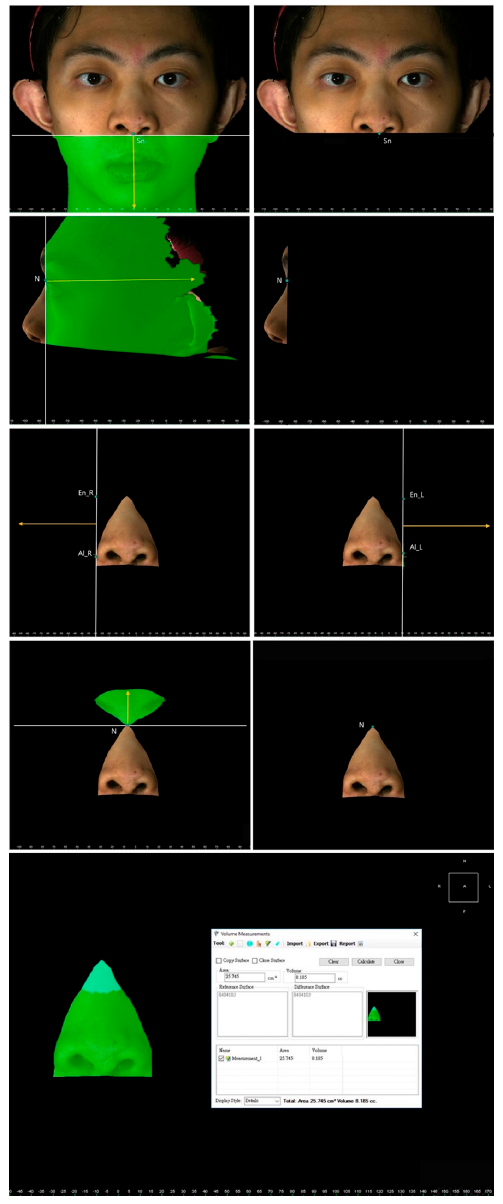
Figure 7. Representation of nasal surface area and nasal volume measurements. The nose was defined